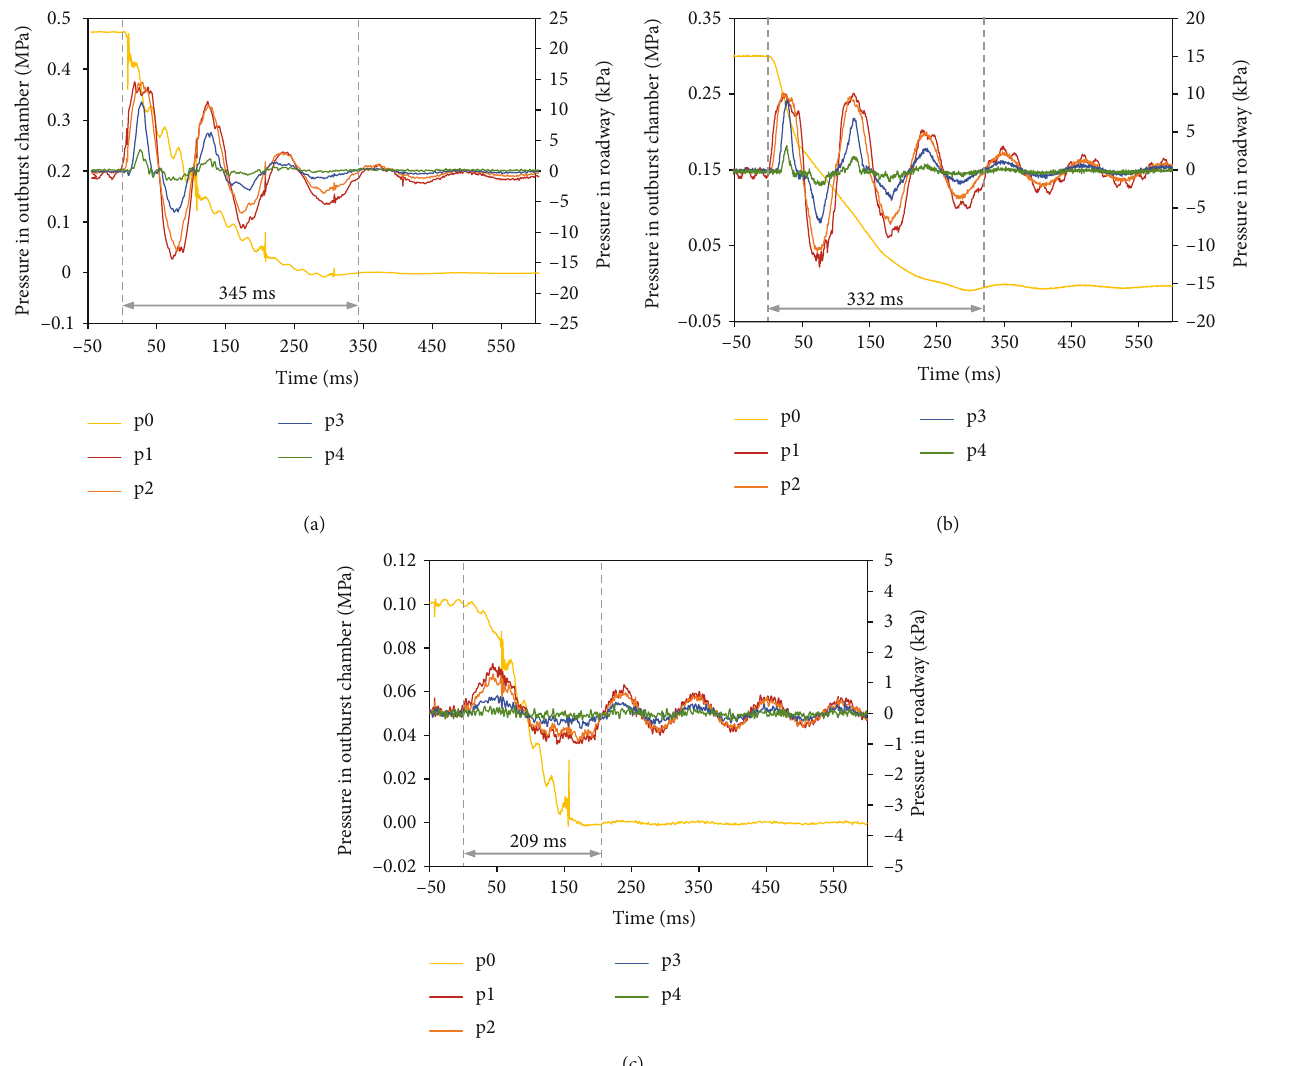
Figure 3: Evolution curve of pressure in outburst chamber and simulation pipeline with time. (a) 0.5MPa; (b) 0.3MPa; (c) 0.1 MPa. Table 2: The peak pressure value of compression wave at di ff erent positions in the roadway. Distance Gas pressure sensor